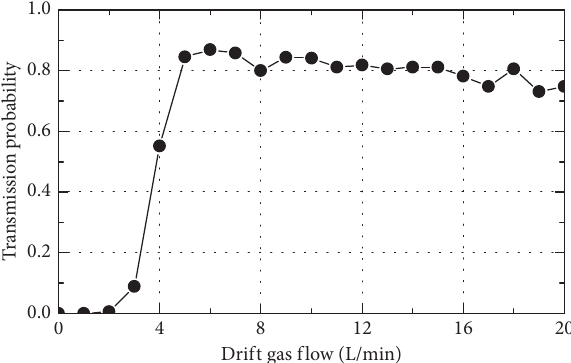
Figure 4: Transmission probability under different gas flow rates when the pressure was